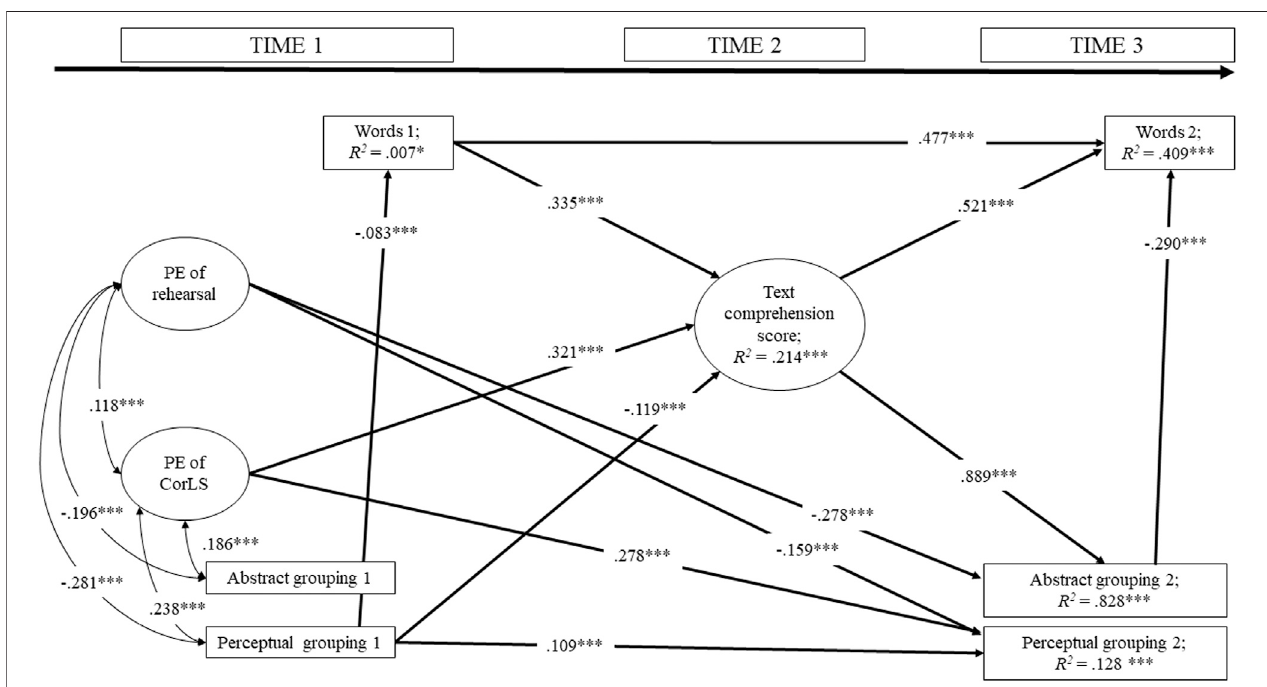
FIGURE 2 | Standardized solution of Structural Equation Model in Grades 3/4. Only signi fi cant paths and correlations are shown; *** p < 0.001.